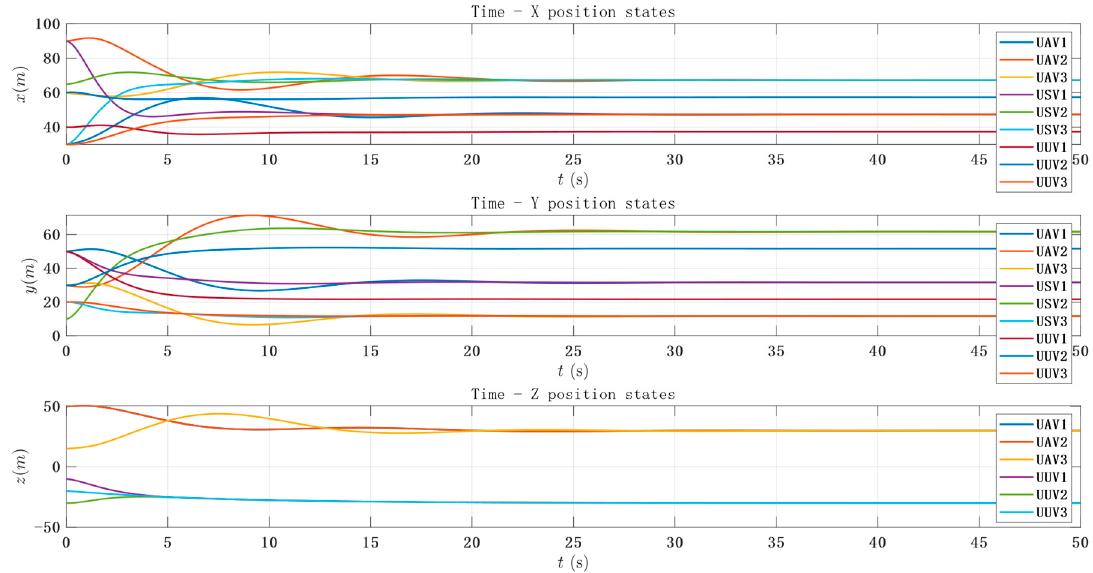
Figure 4. Position state with static formation control.